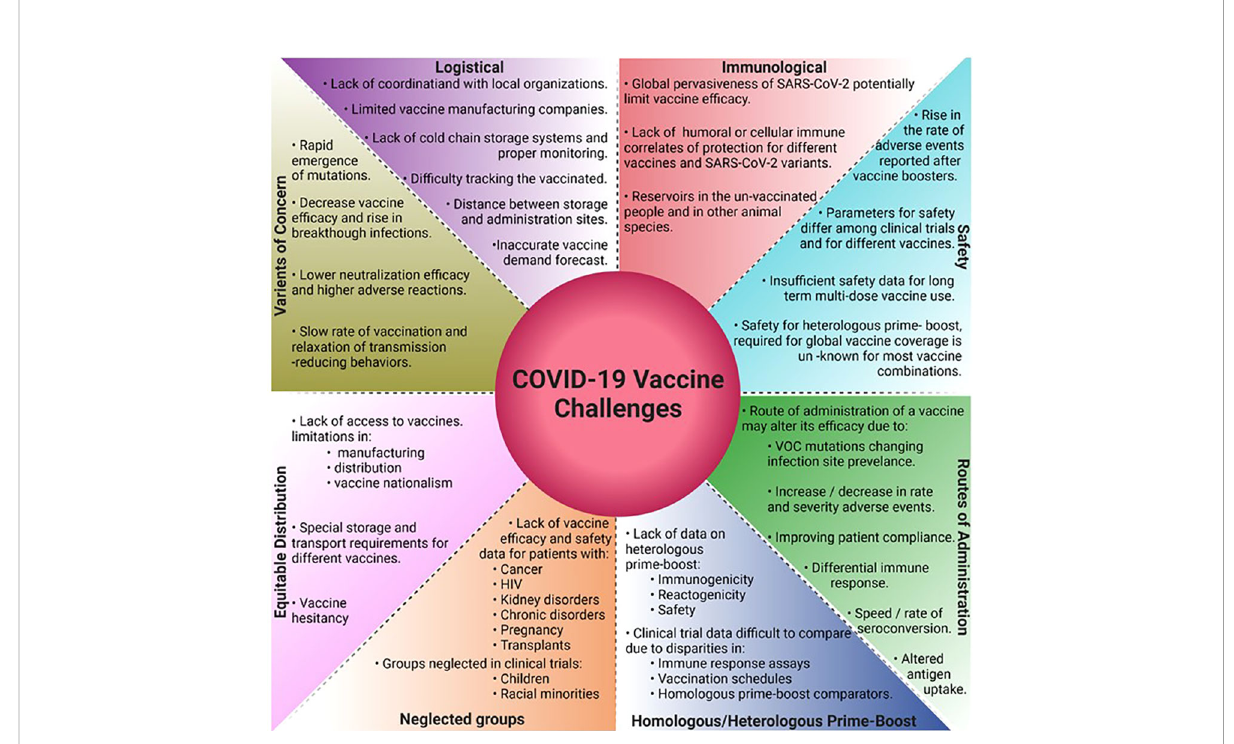
FIGURE 4 Challenges in the development and deployment of COVID-19 vaccines, and the path